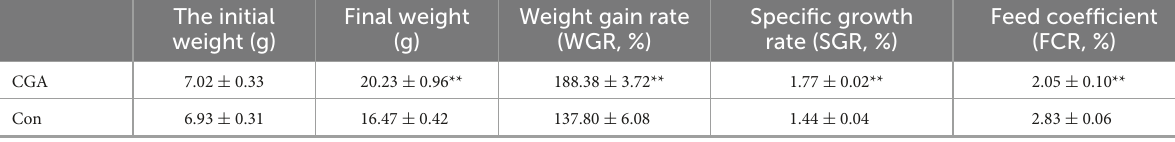
TABLE 2 Effects of chlorogenic acid on growth performance of Carassius auratus .